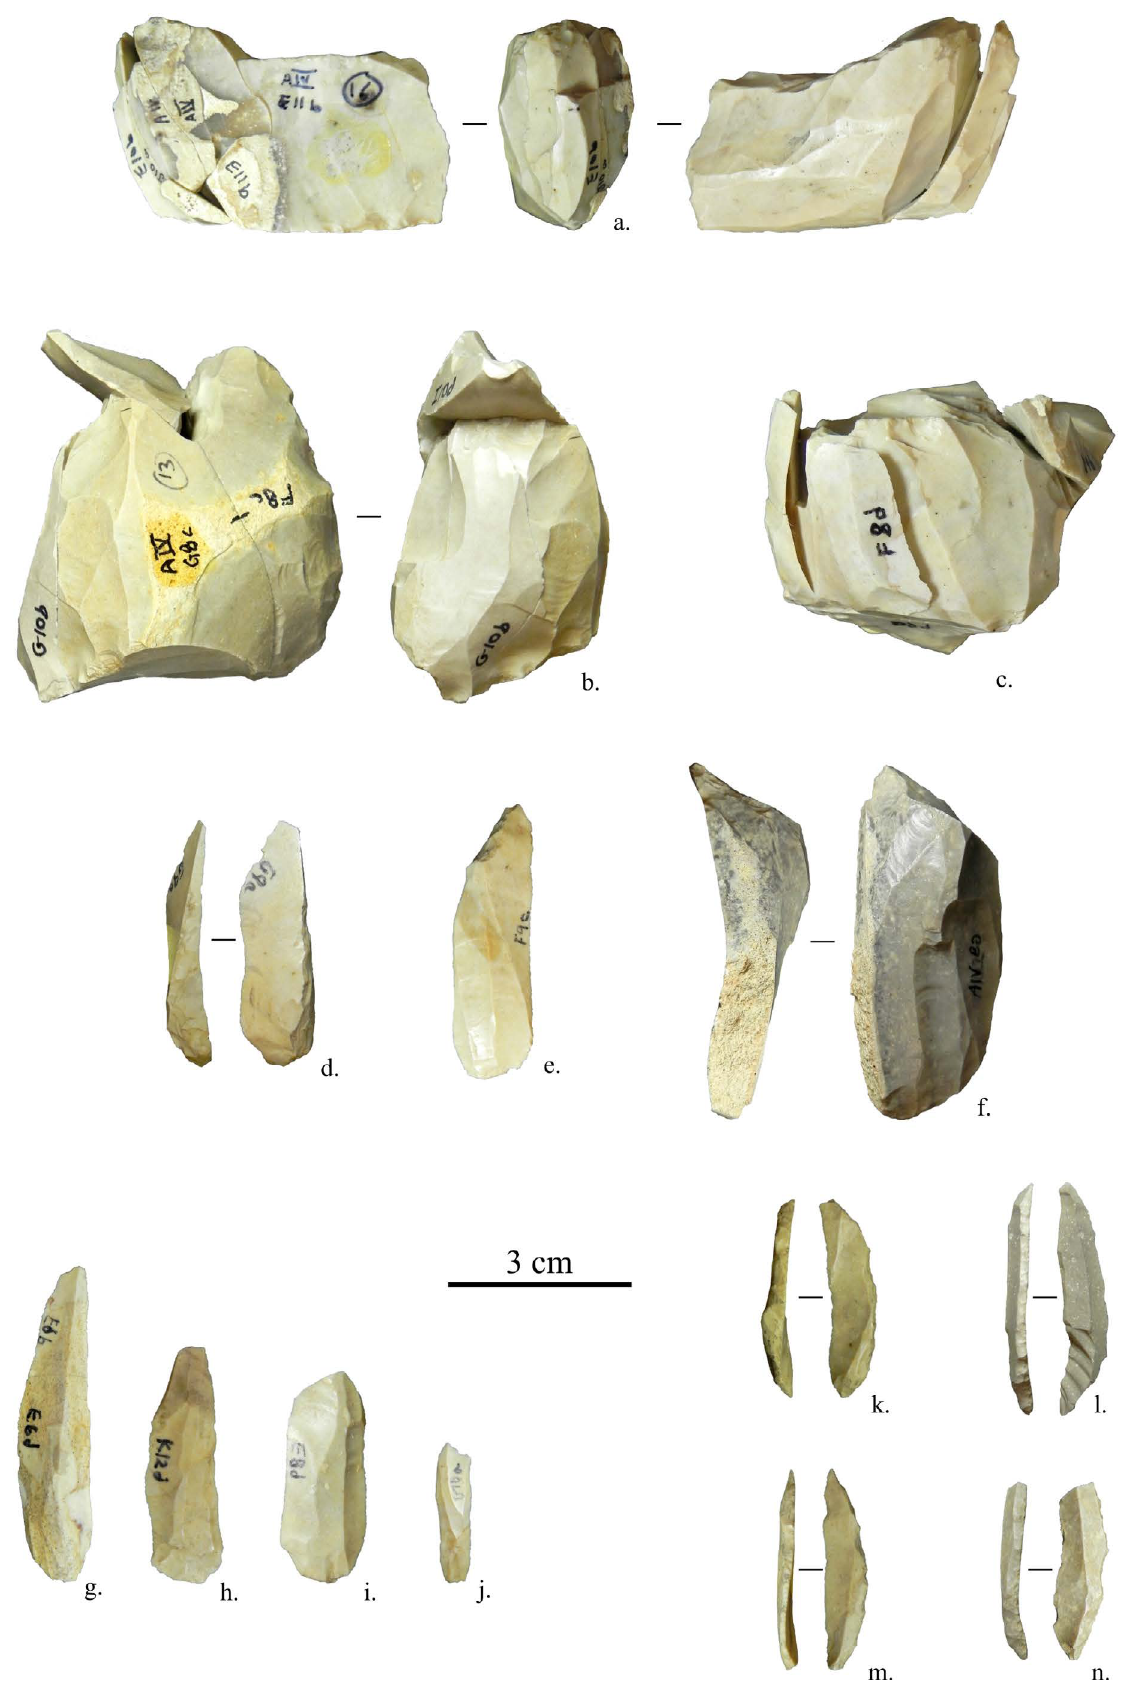
Figure 3. Azariq IV - lithic artefacts. (a-c) refits of cores with blade(lets), (a) on split; (d-f) core trimming elements; (g-j) elongated blanks, (k-n) backed